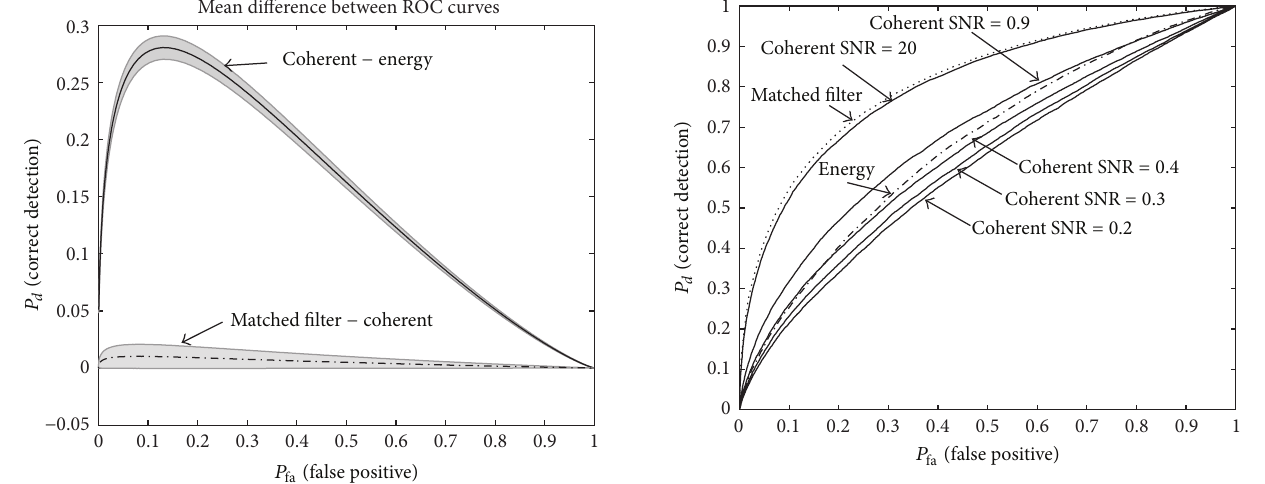
Figure8:DifferenceinROCcurvebetweenthecoherentandenergy detectors and between the matched filter and coherent detectors.